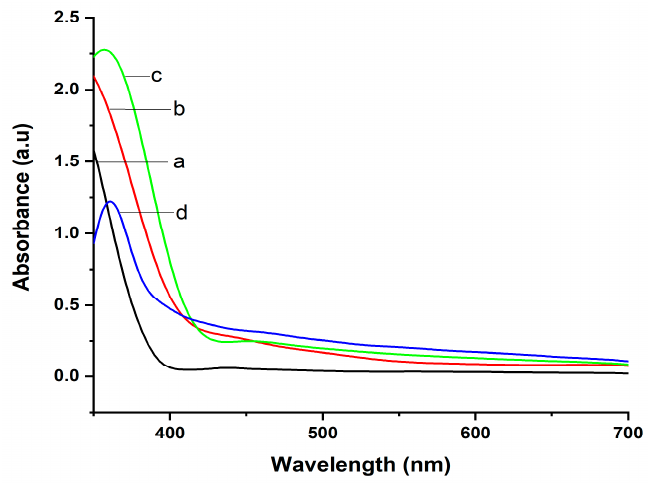
Figure 1. The DRUV Spectra of ( a ) TiO 2 , ( b ) TiO 2 –N (5) ( c ) TiO 2 –N (10) and ( d ) TiO 2 –N (15). Table 1. The effect of N doped into TiO 2 on band gap energy.